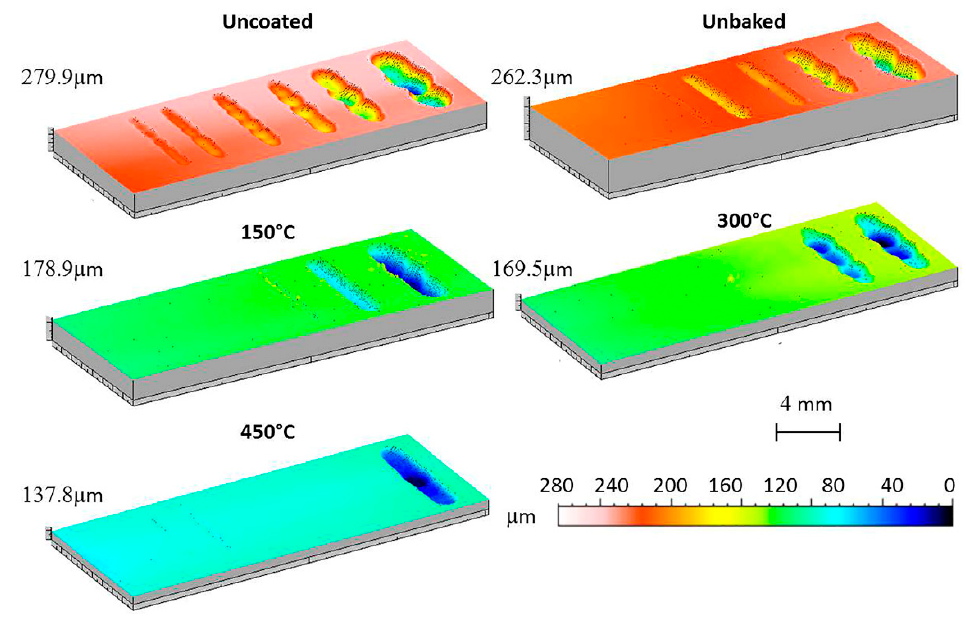
Figure 11. Images of the linear reciprocating trails.